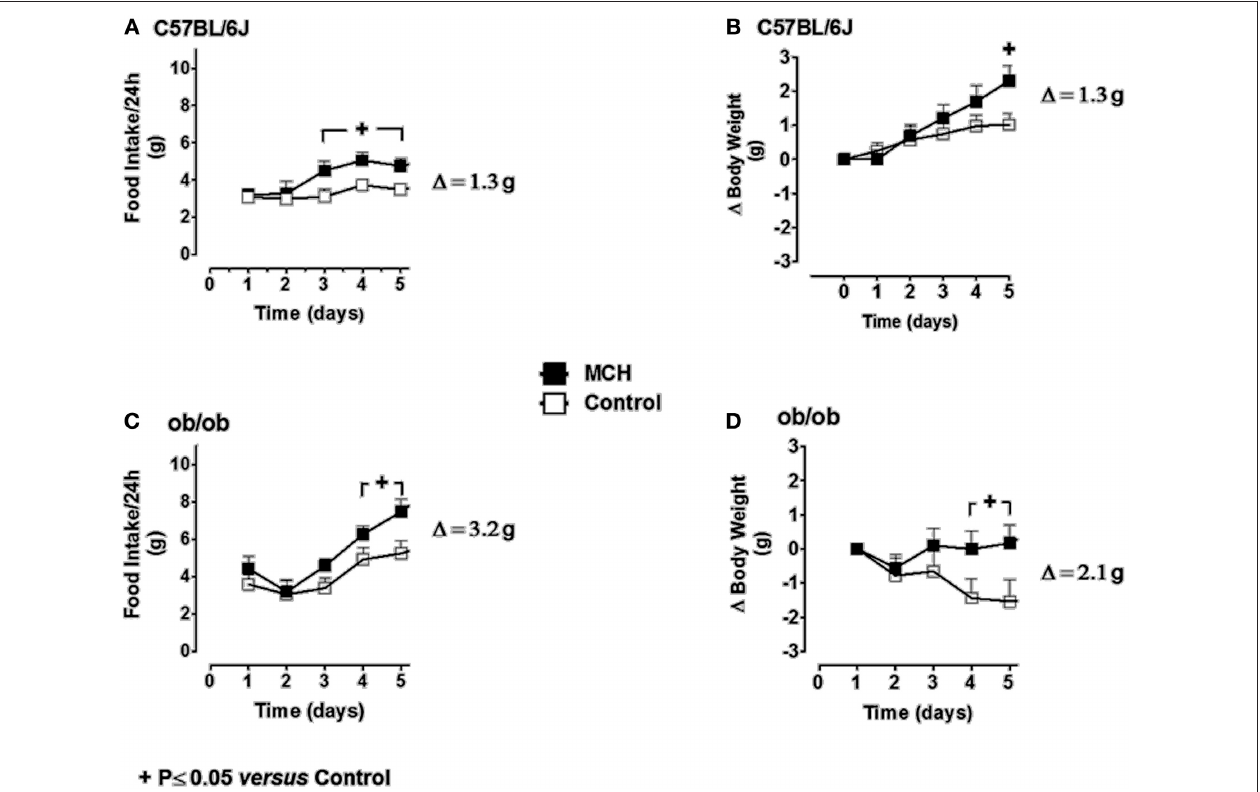
FIGURE 7 | The effect of repeated daily central administration of MCH to lean (C57BL/6J) and obese ( ob/ob ) mice. C57BL/6J ( A and B ) and ob/ob ( C and D ) mice were administered MCH (5 μ g/mouse/day) or artificial cerebrospinal fluid vehicle through i.c.v. injections for 5 consecutive days.